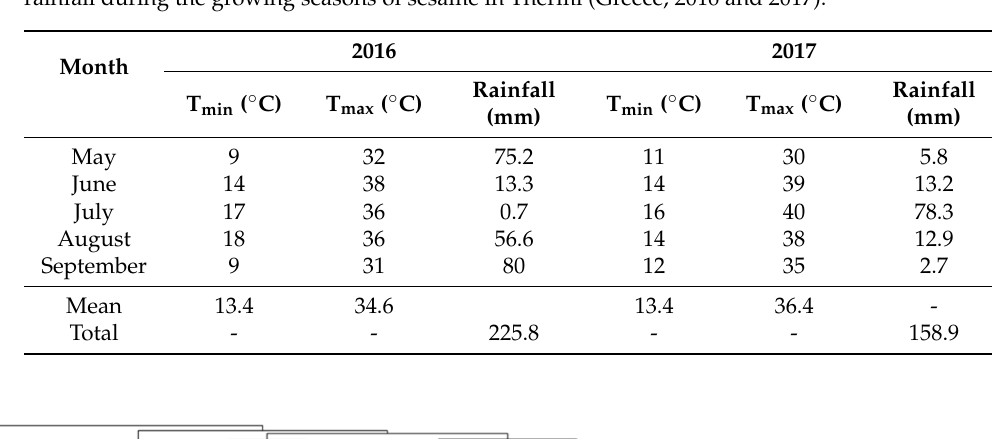
Table 1. Monthly mean maximum temperature (T max ), minimum temperature (T min ) and total